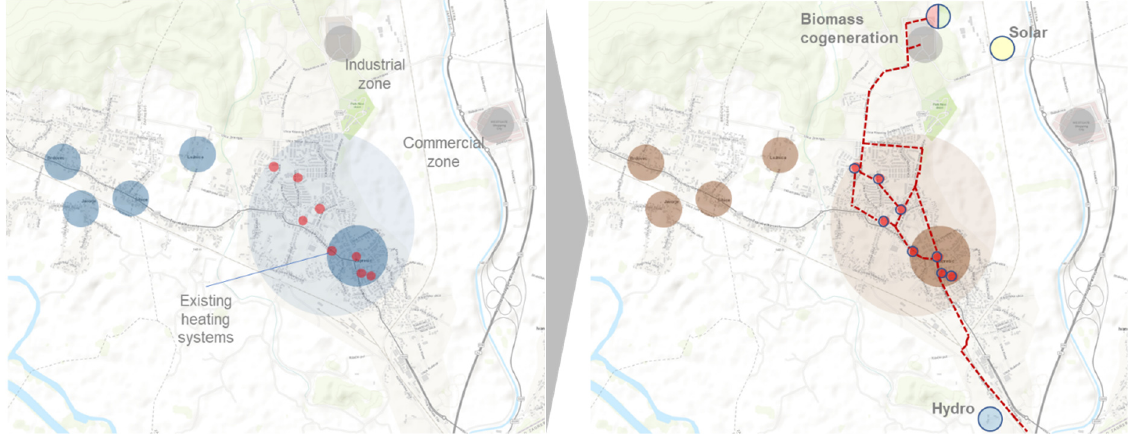
Figure 9. The city’s potential RES deployment locations.